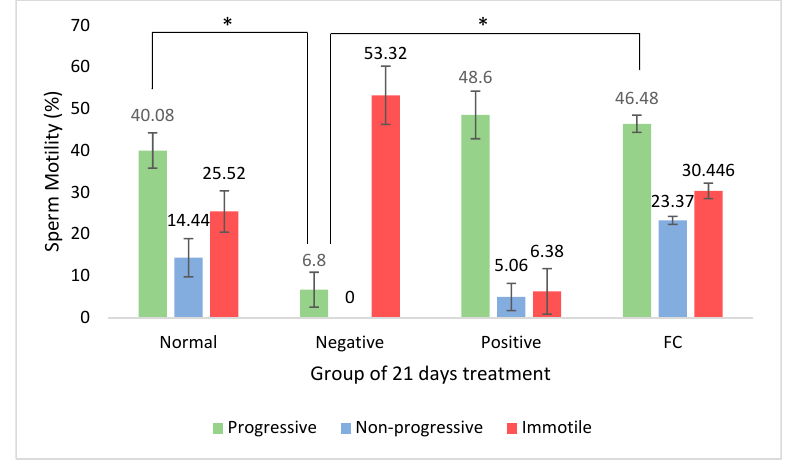
Figure 3. Sperm motility (%) of rats from normal (normal group with distilled water), negative (diabetic group with distilled water), positive (diabetic group with 300 mg/kg metformin), and FC (diabetic group with 400 mg/kg Ficus carica aqueous extract). Symbol “ * ” represents significant difference ( p < 0.05).